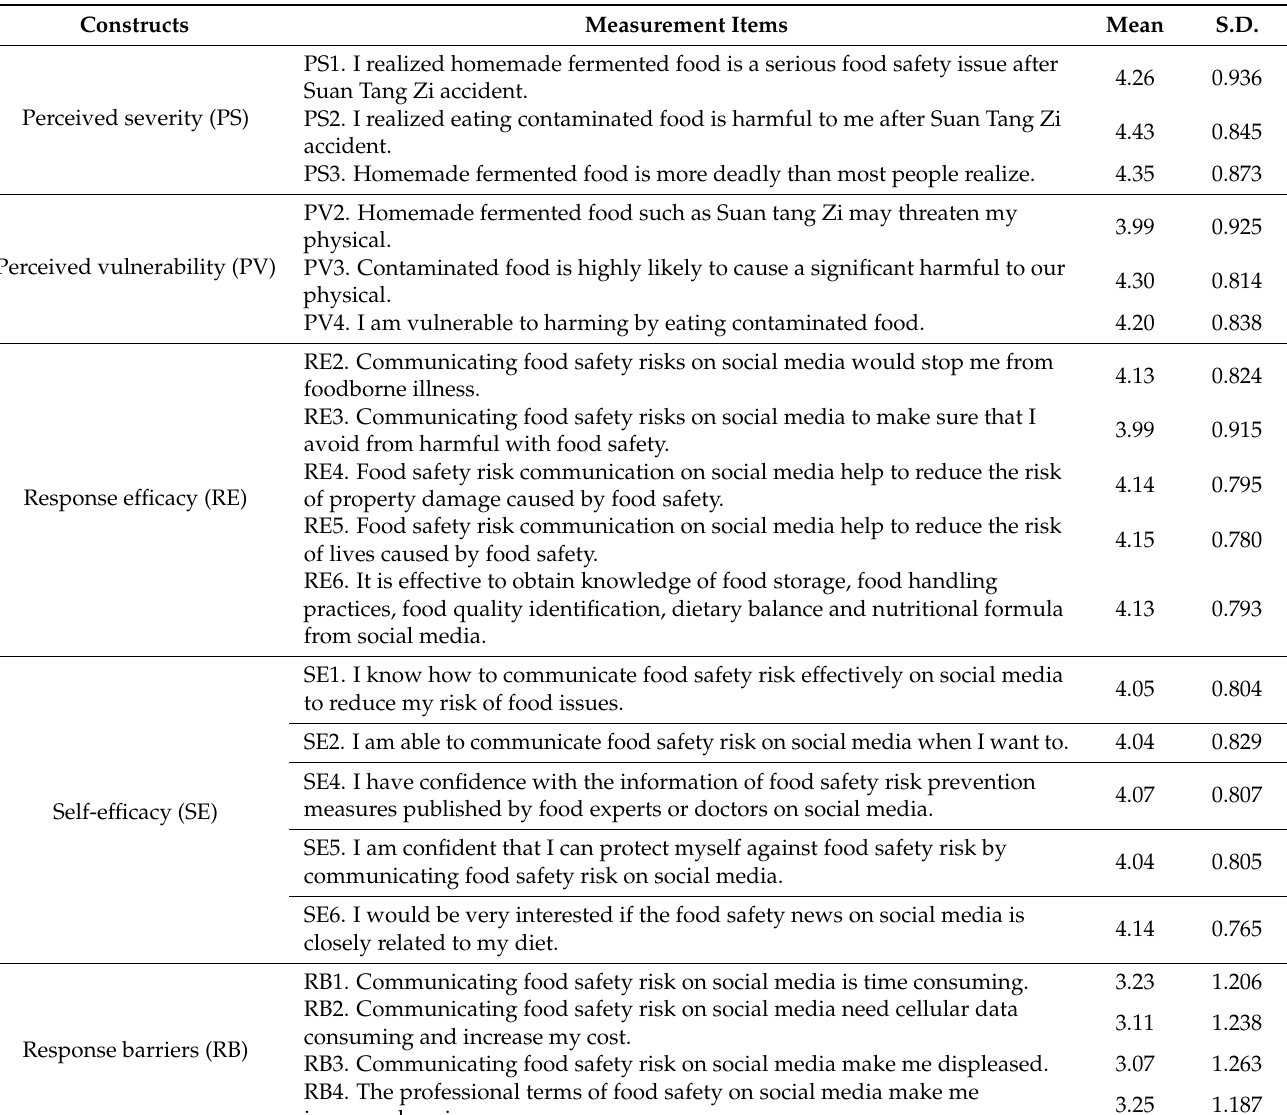
Table 1. Constructs and measurement